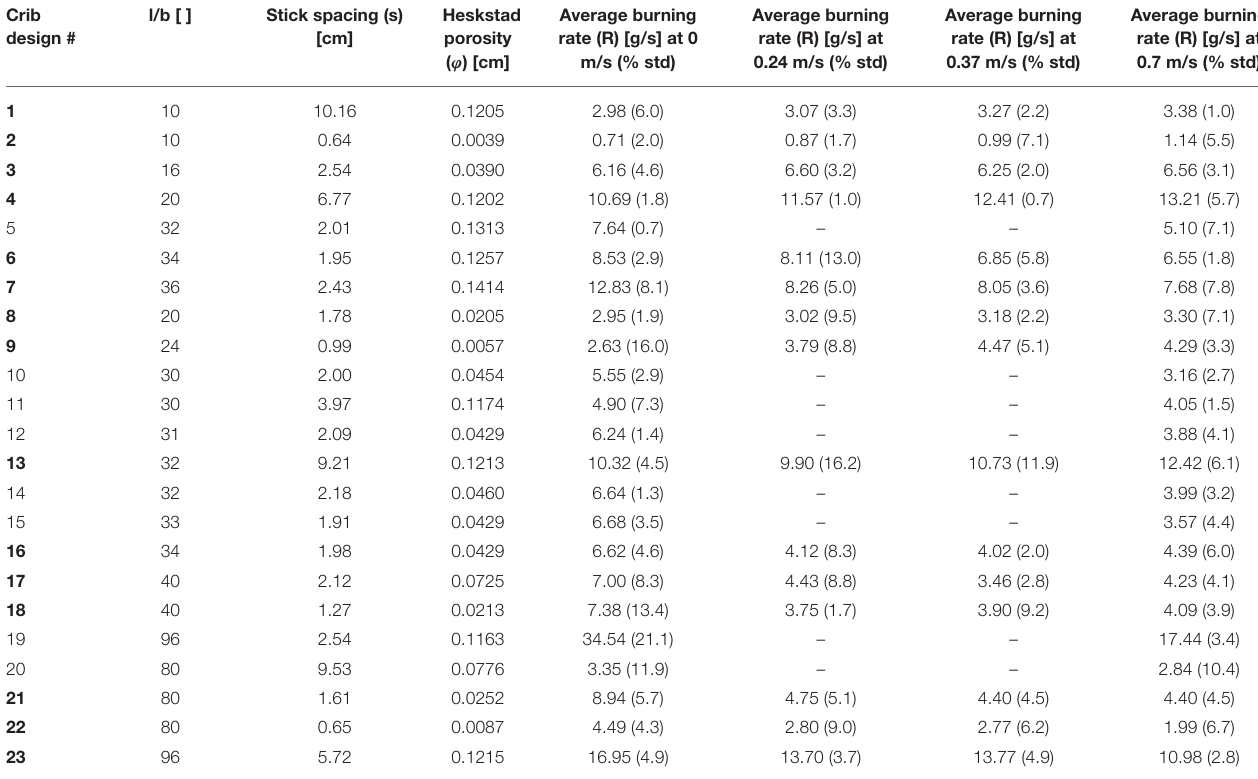
TABLE 2 | Burning rate results averaged over three replicates. Crib design #